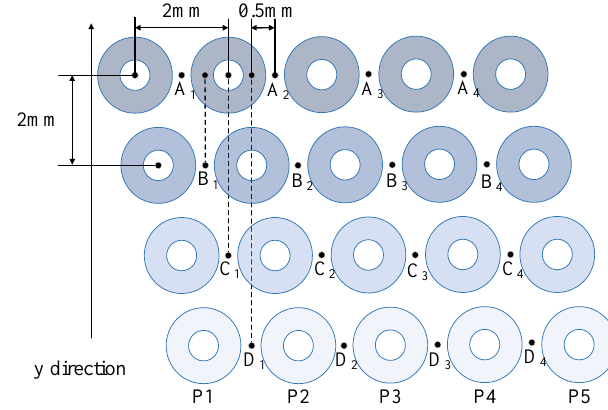
Figure 1. Coils layout of the resolution enhanced